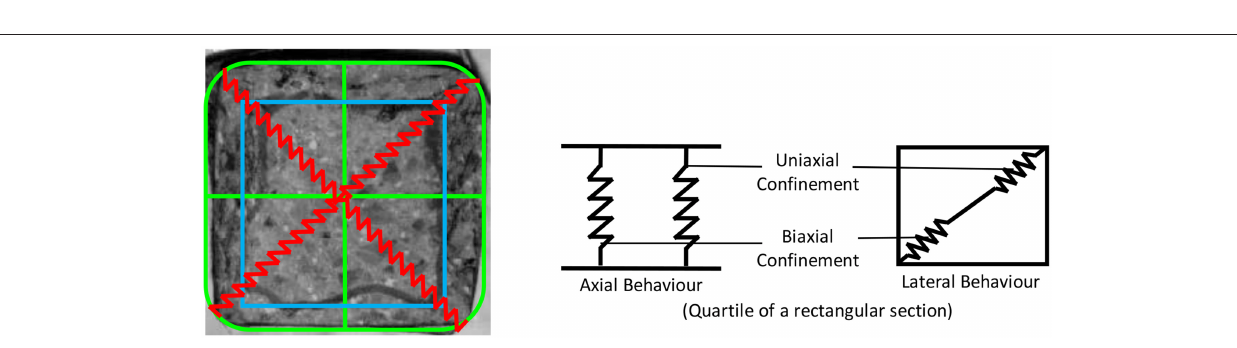
FIGURE 5 | FRP-confined rectangular concrete section modeling using “generalized”